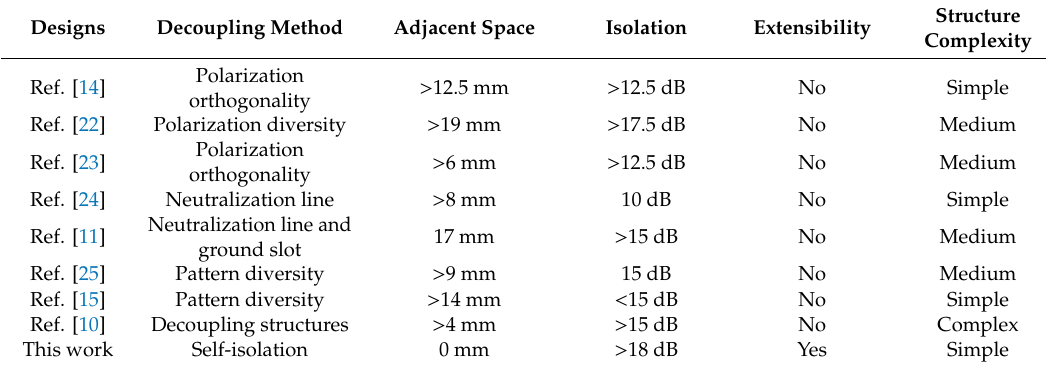
Table 2. Performance comparison between the proposed design with previous multi-element MIMO antenna